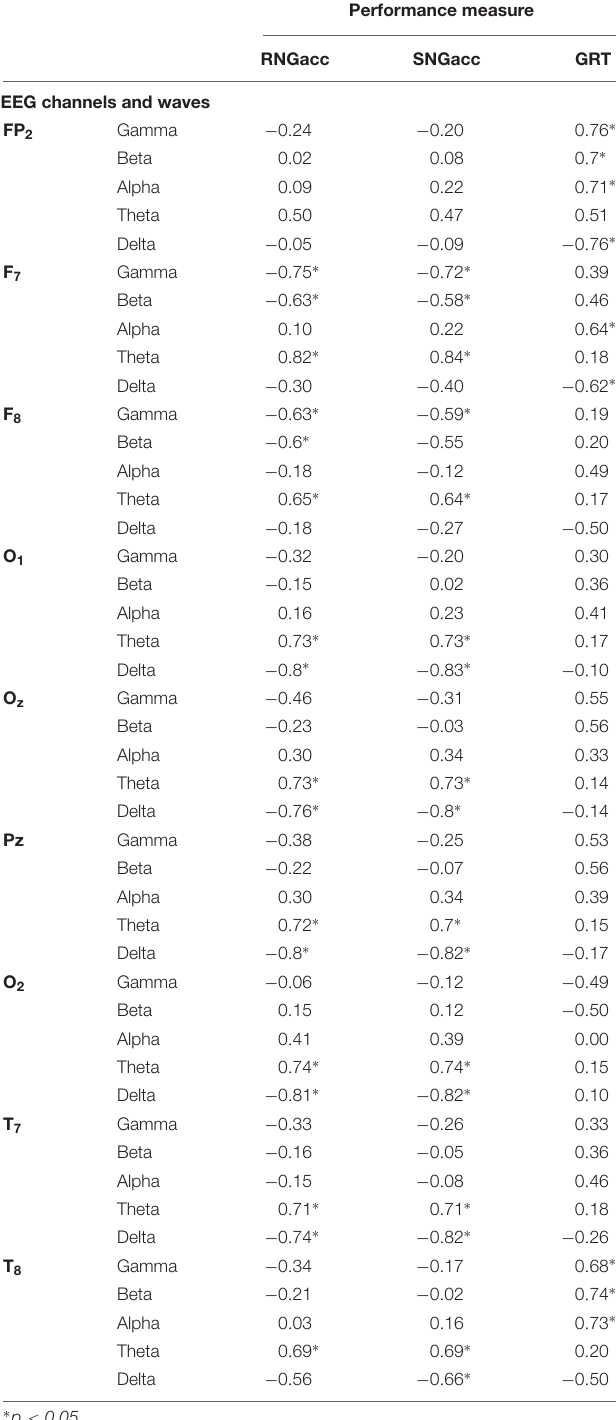
TABLE 1 | Correlation ( r ) between EEG measures and performance